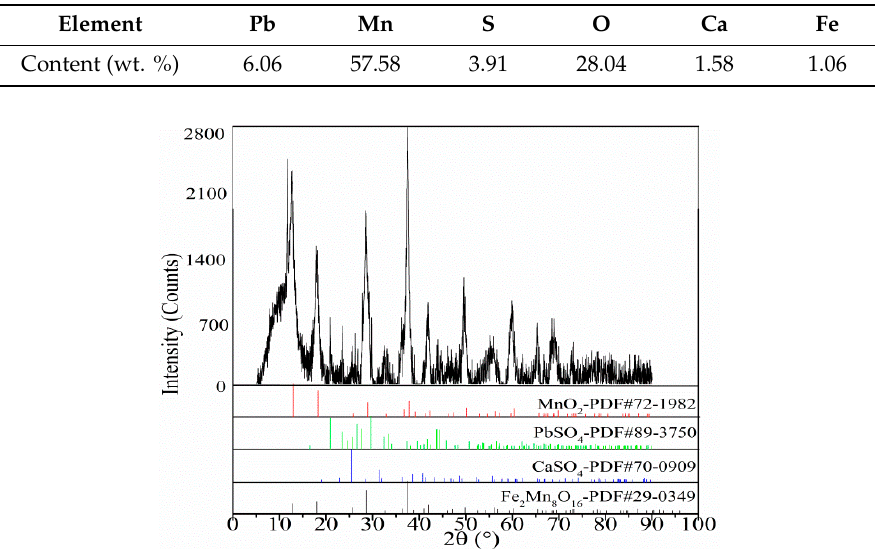
Figure 1. X-ray diffraction (XRD) pattern of the electrolytic manganese anode mud.